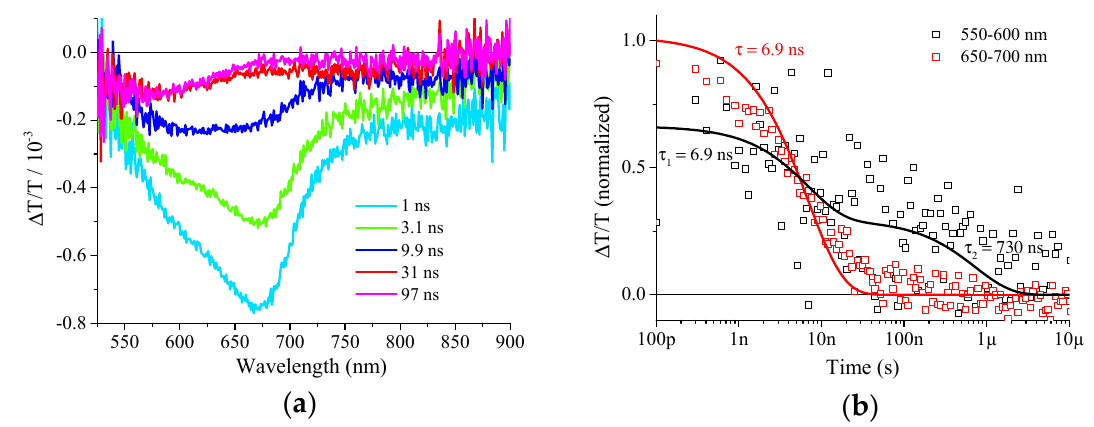
Figure 5. Transient spectra at different delay times after excitation with 355 nm ( a ) and decay dynamics tracked from 550–600 nm and 650–700 nm ( b ).